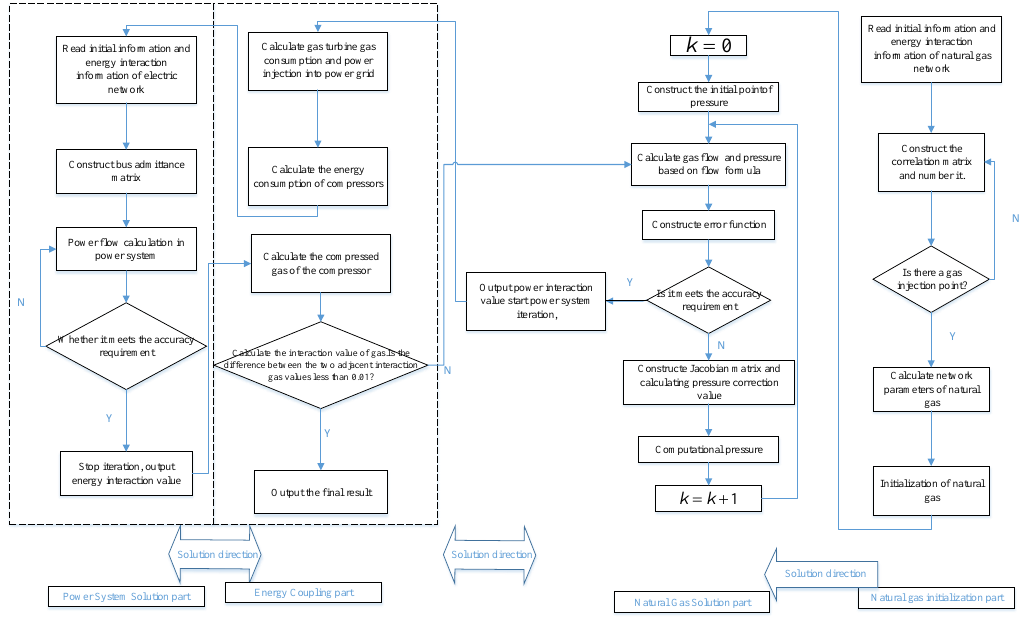
Figure 1. Steady-state energy flow calculation in an integrated energy systems.